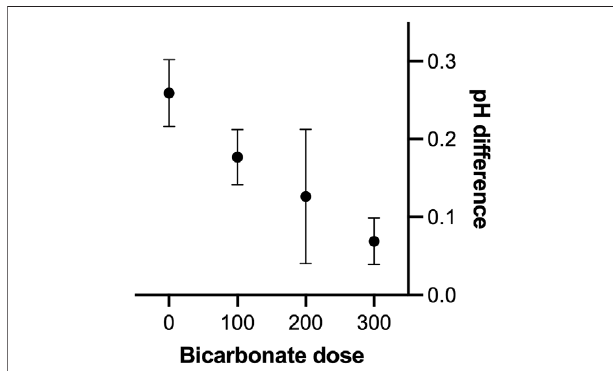
FIGURE2| Estimated rowinginduceddecreaseinplasmavolume(%)in trials with administration of bicarbonate (square) compared to control (circle). † , difference between rowing with bicarbonate and control; p <